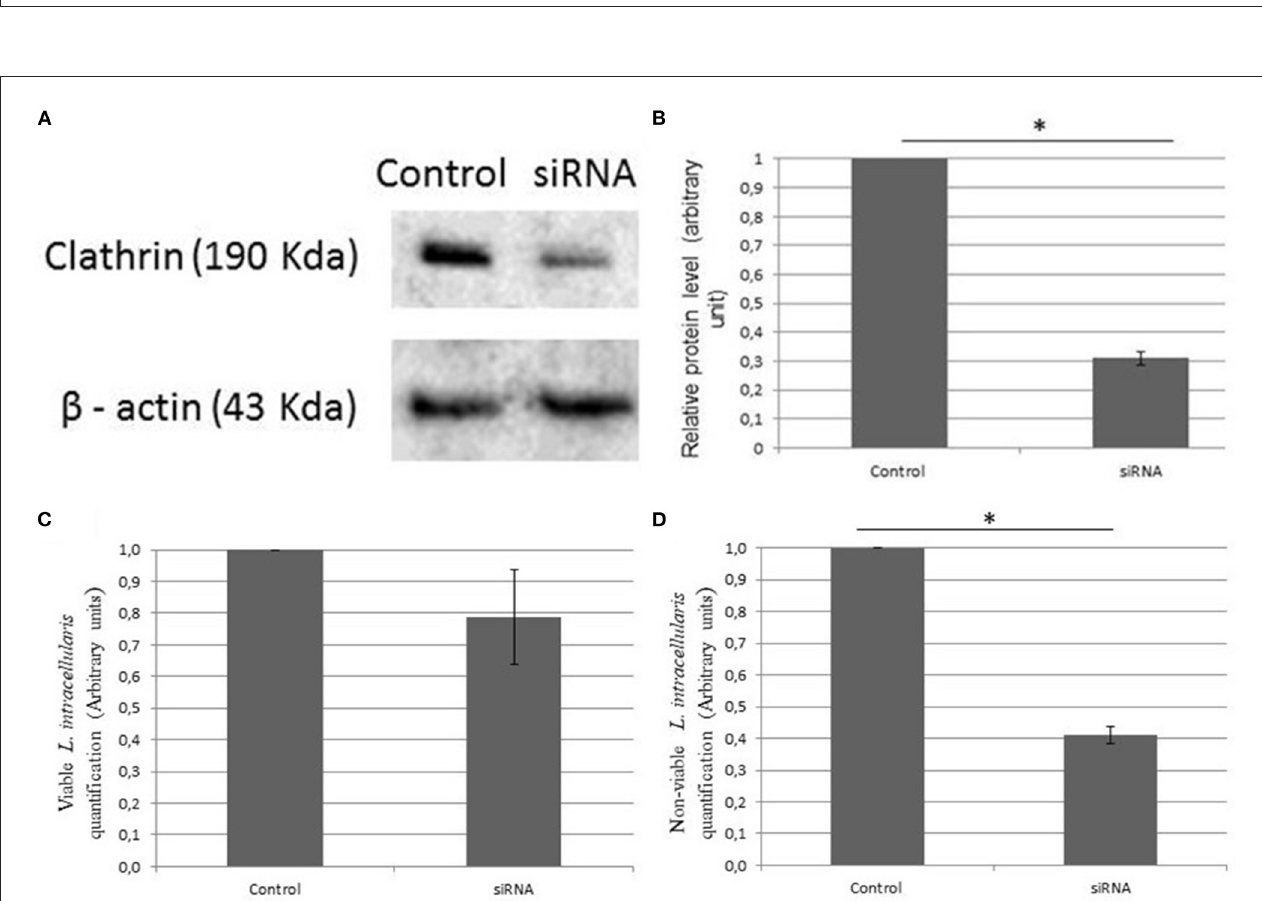
FIGURE2 (A) Effect of clathrin knockdown using Western blot. The expression of clathrin in culture of IPEC-J2 infected with L. intracellularis demonstrated a lower expression rate of clathrin in the transfected group (siRNA). β -actin was used as loading control. (B) The relative protein levels analyzed by ImageJ and standard deviation. (C, D) The evaluation of the amount of L. intracellularis endocytosis in the different groups was performed using RT-PCR. Results are presented as the means ± SD of three independent experiments, using control groups (IPEC—J2 infected with L. intracellularis ) and siRNA groups (IPEC—J2 knockdown to clathrin and infected with L. intracellularis ). (C) Live L. intracellularis amounts did not differ statistically in the control and transfected group and (D) heat killed L. intracellularis had a reduced internalization rate (* P < 0.05) in the transfected group when compared to the